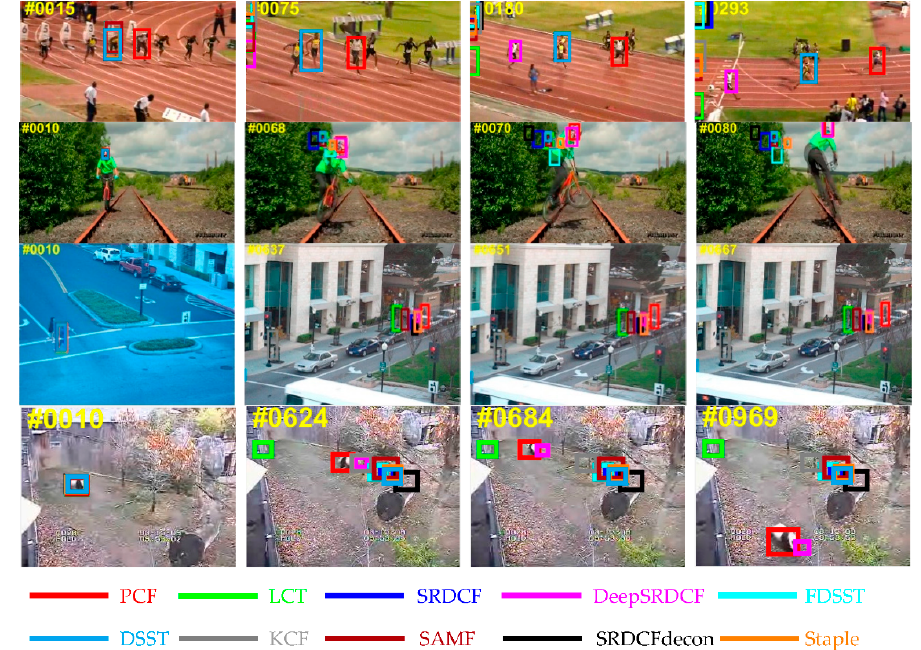
Figure 12. The qualitative experiments from four representative videos on the OTB-2015 benchmark. The results for the top ten trackers are marked in different colors. In these challenging videos, the proposed PCF tracker performs better than the other top nine trackers.